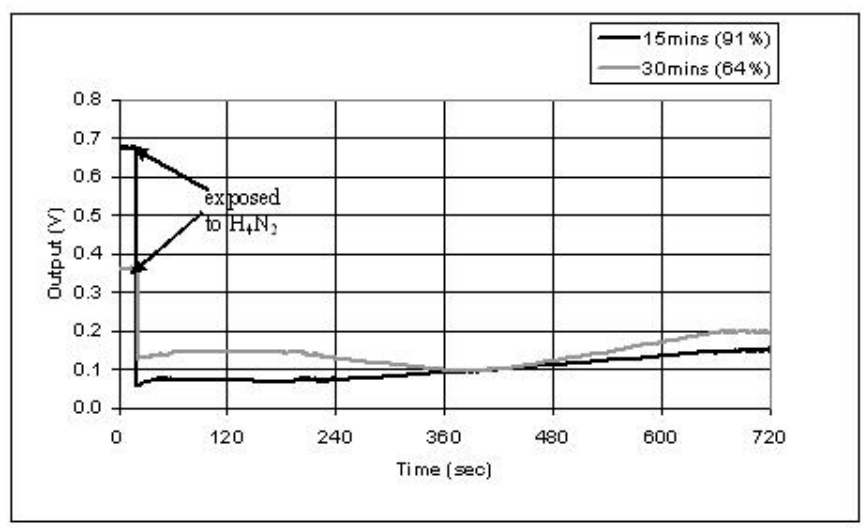
Figure 13. Sensor response to chemical vapor of hydrazine (H